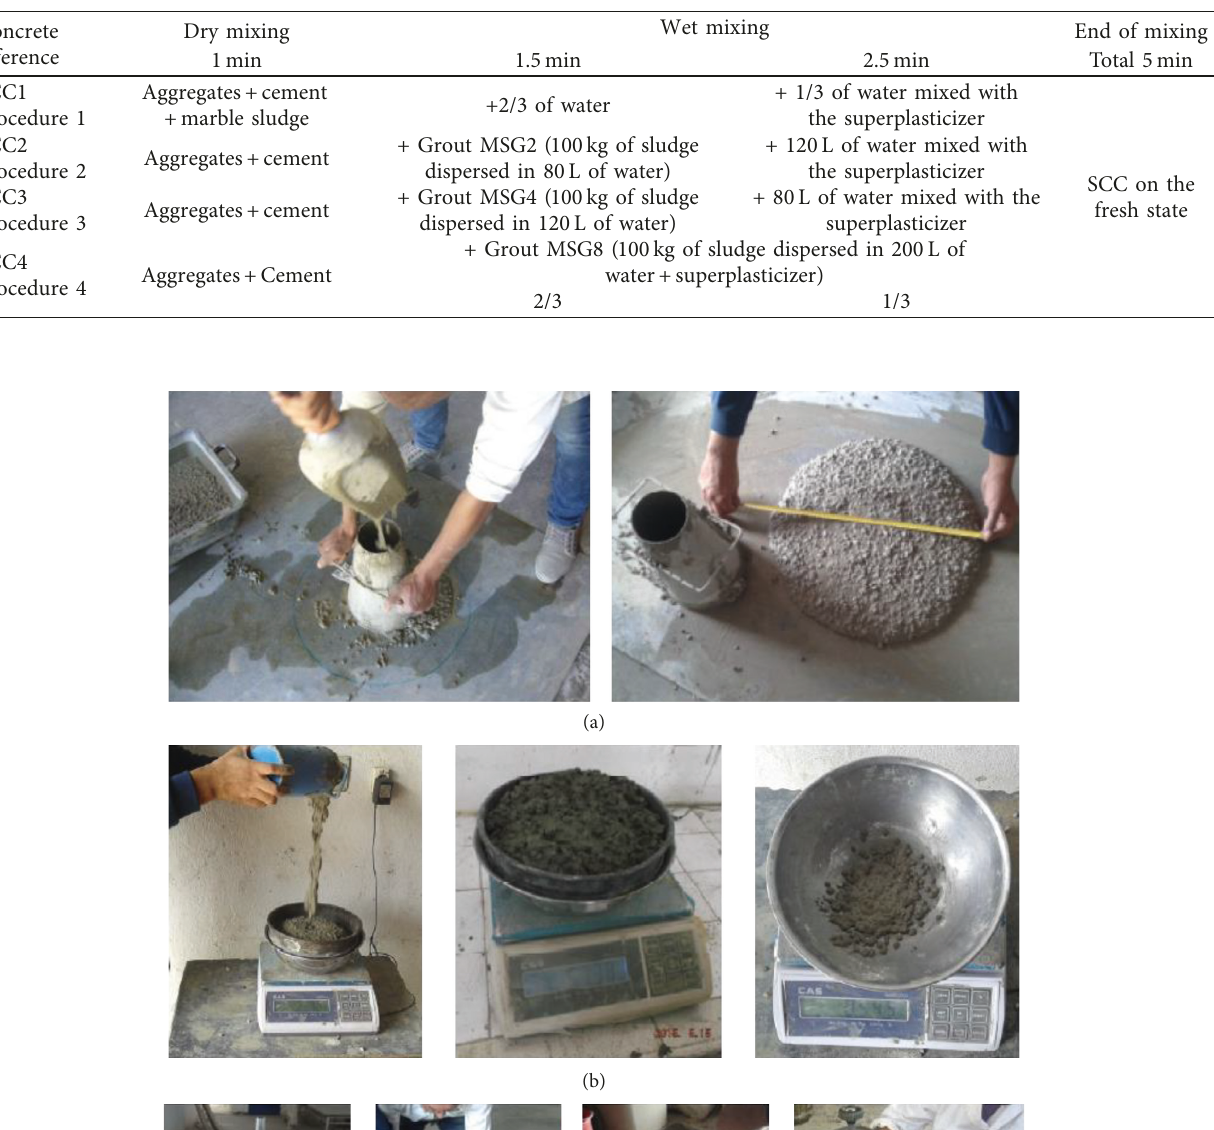
Table 7: The different mixing methods.